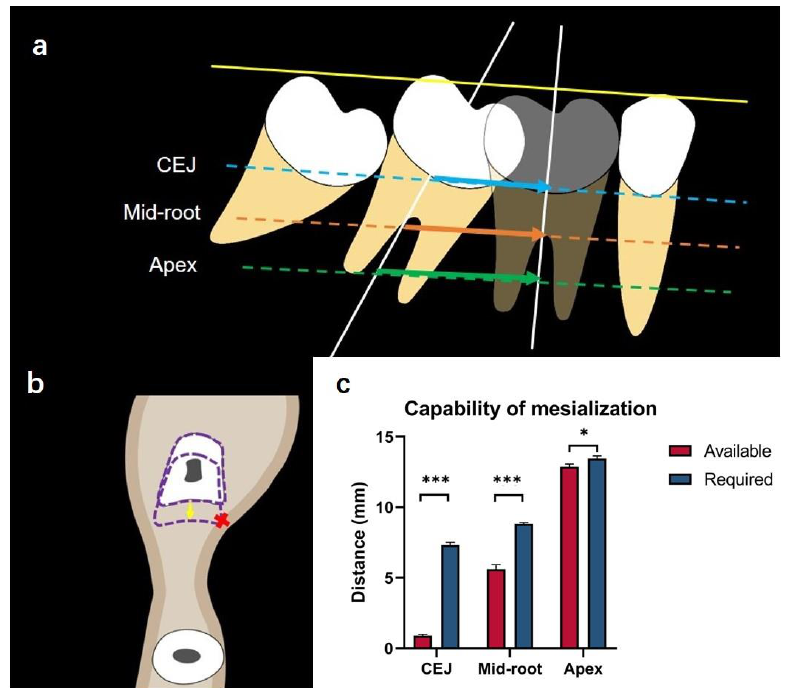
Figure 9. ( a ) Illustration showing the measurements of required mesialization distances. ( b ) Illus- tration showing the measurements of available mesialization distances. ( c ) Available and required mesialization distances at CEJ, mid-root, and apex levels. * indicates p < 0.05, *** indicates p < 0.001.